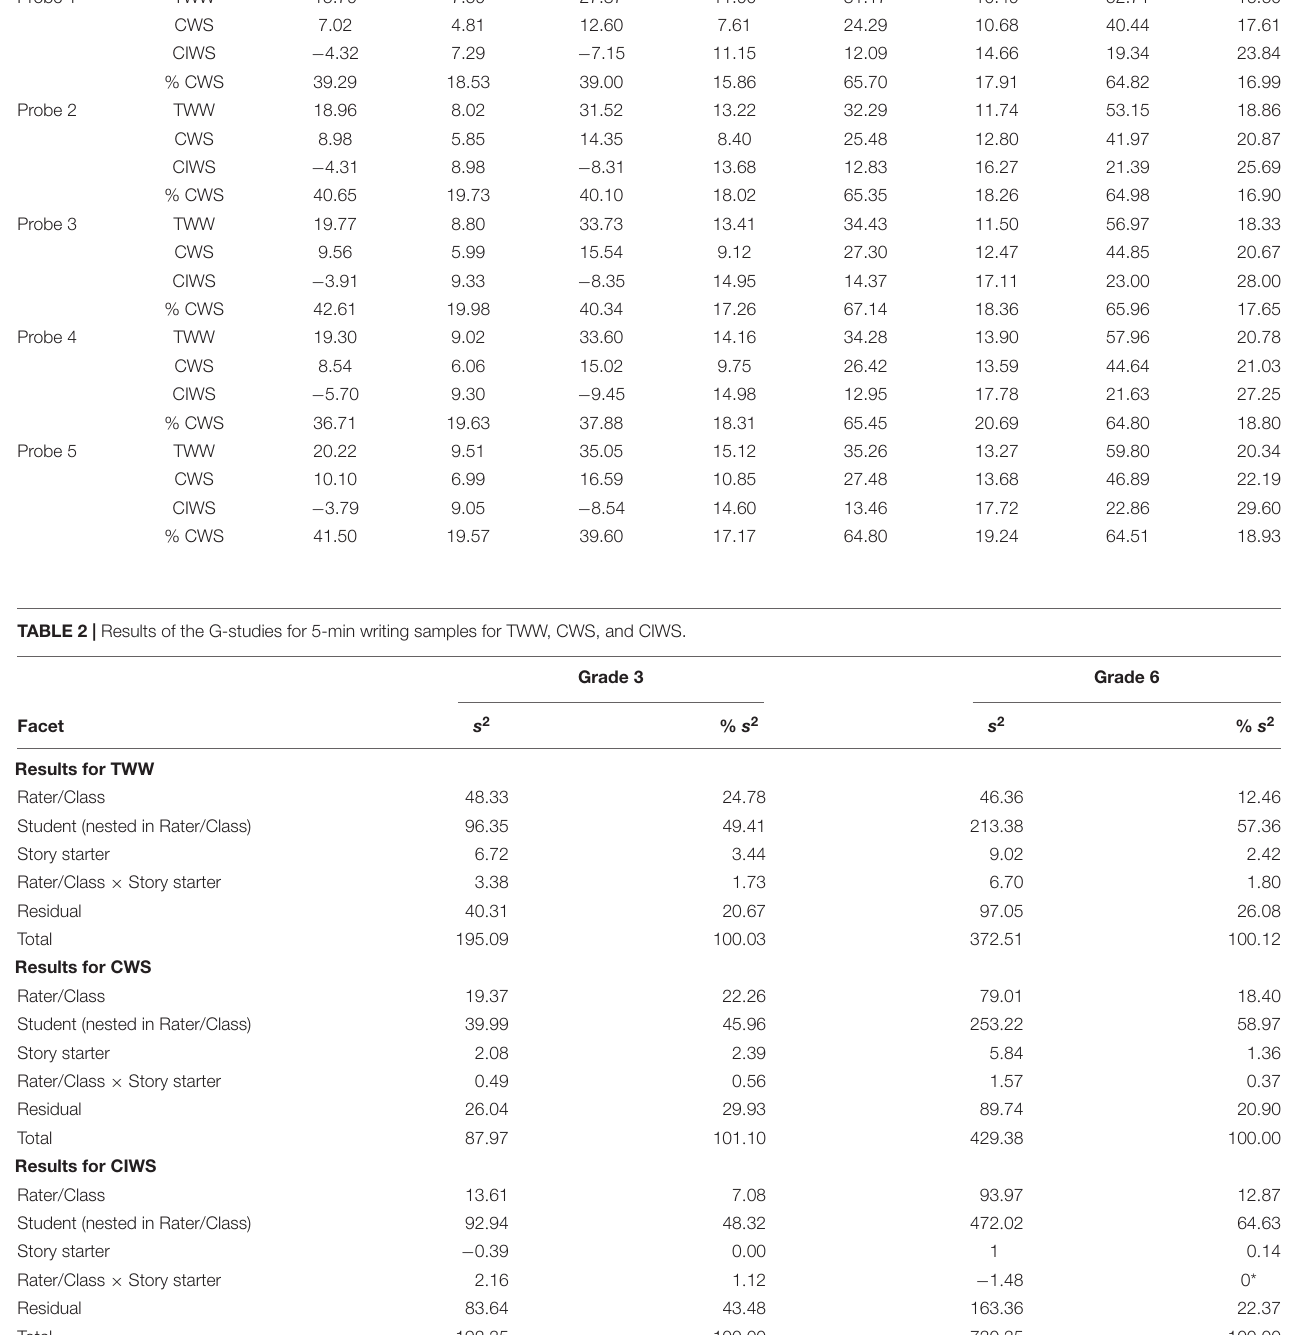
TABLE 1 | Descriptive statistics (M and SD).